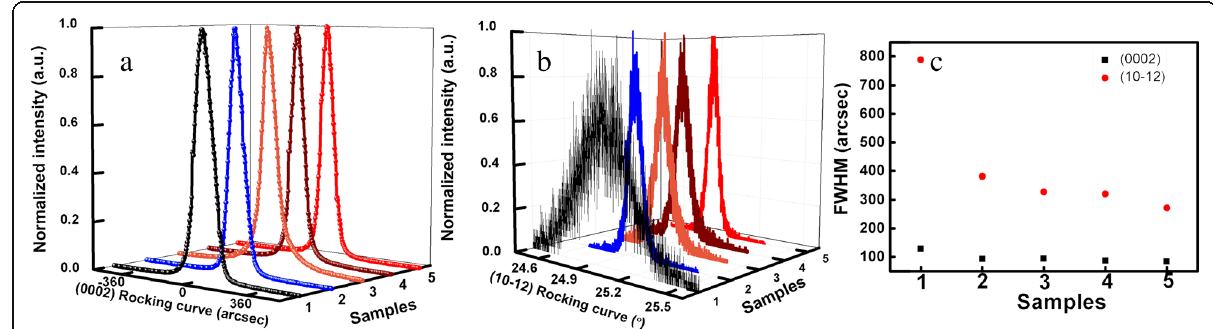
Fig. 1 a The (0002) plane XRC of five AlN samples. b The (10-12) plane XRC of five AlN samples. c The FWHM of (0002, 10-12) plane XRC; the red circle means the FWHM of (10-12) plane and black square represents the FWHM of (0002)